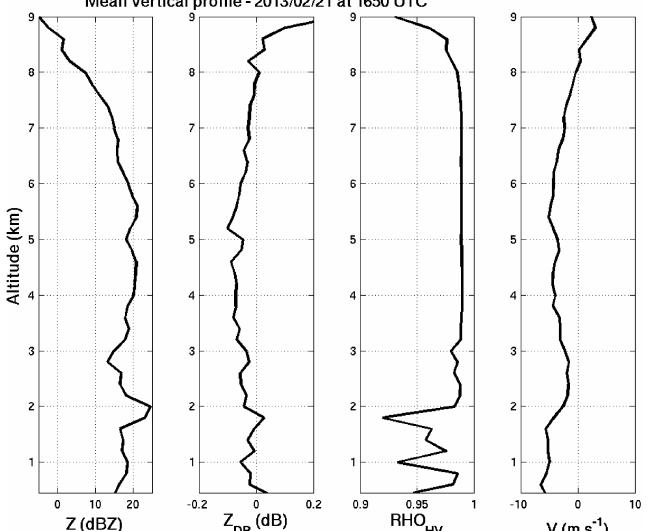
Figure 4. Mean vertical profiles of reflectivity, differential reflectivity, correlation coefficient, and Doppler velocity observed on 21 Febru- ary 2013 at 16:50UTC.